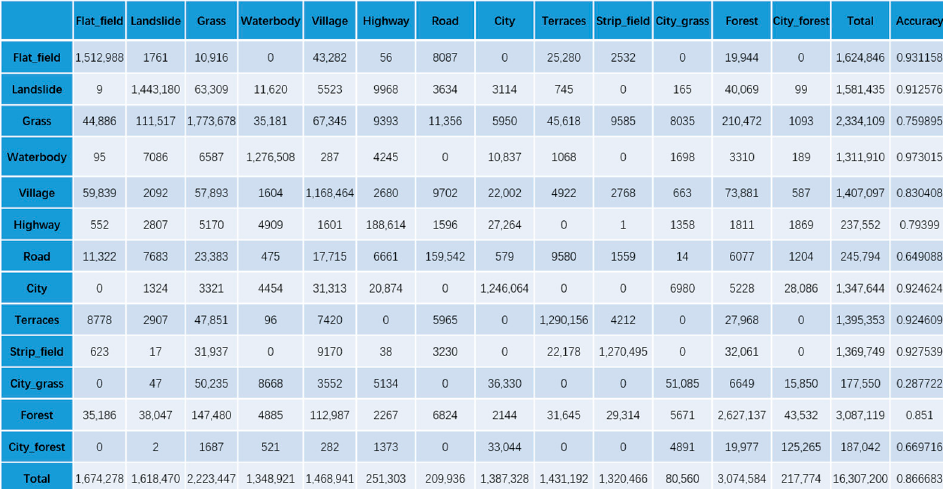
Figure 17. The pixel-based confusion matrix of the Cluster-GCN model.